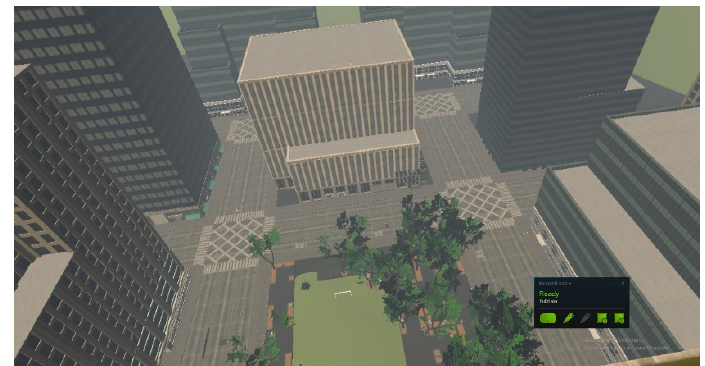
Figure 4. The virtual environment, view of the building from the ground floor.